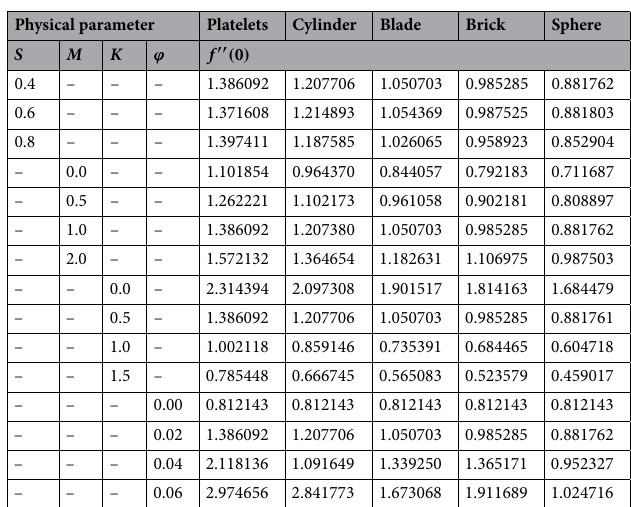
Table 3. The skin-friction coefficient’s numerical values for multi-shaped nanoparticles.